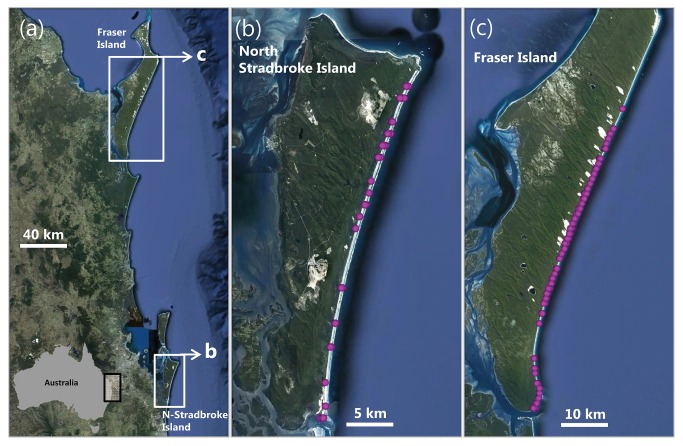
Location of the study sites, Fraser and North Stradbroke Island, in Eastern Australia (a) and positions of focal observations (purple circles) on vehicle-bird interactions on the open-coast beaches of North Stradbroke (b) and Fraser Island (c).